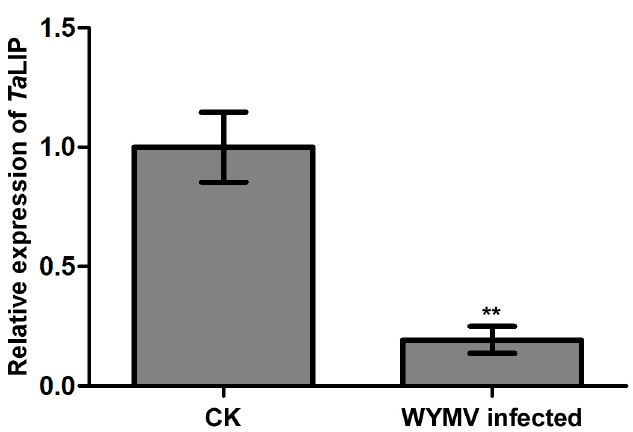
Figure 5. The expression level of TaLIP was significantly downregulated in WYMV-infected wheat. TaCDC was used as the internal control. The level of TaLIP in health wheat was normalized to 1. Each relative expression level is presented as the mean ± SD from four biological samples and each biological sample had four technical replicates. Statistical analyses were done using the Student’s t -test. Asterisks indicate a significant difference when compared to the control. * p < 0.05; ** p < 0.01.